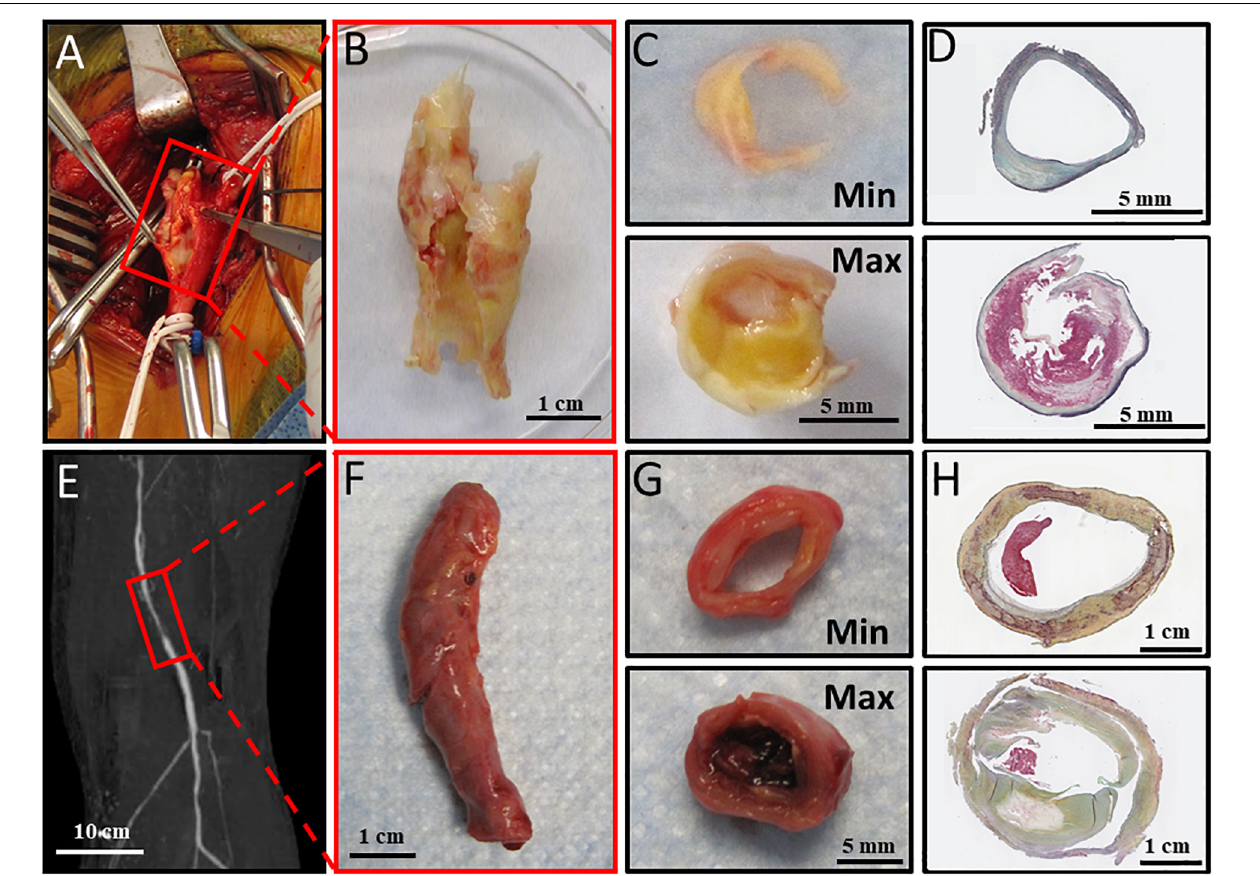
FIGURE 1 | Atheroprogression of carotid artery bifurcation and lower extremity. (A) Carotid bulb before endarterectomy, (B) Carotid endarterectomy harvested from operating room, (C) Carotid Endarterectomy sectioned into Min and Max diseased sections. (D) Carotid endarterectomy Min and maximally Max sections with Movat Pentachrome staining. (E) Preoperative imaging showing reduced perfusion in the popliteal artery. (F) Dissected popliteal artery collected immediately from operating room. (G) Anterior tibial artery sectioned into minimally (Min) and maximally (Max) diseased components. (H) Min and Max sections stained with Movat Pentachrome staining. Movat pentachrome stains elastic fibers black, Nuclei Blue, Collagen Yellow, reticular fibers yellow, mucin bright blue, and fibrin